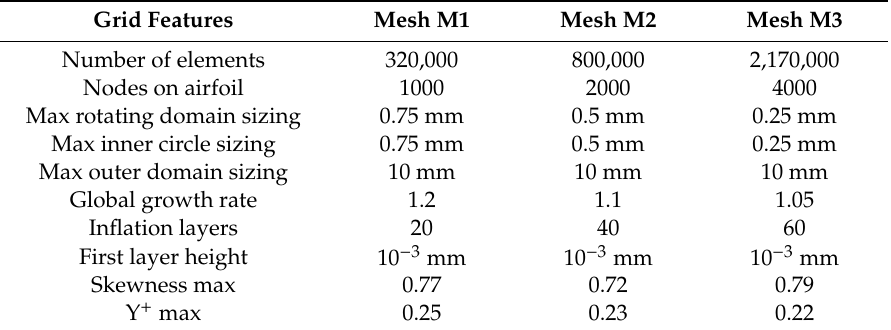
Table 2. Grid independence study meshing